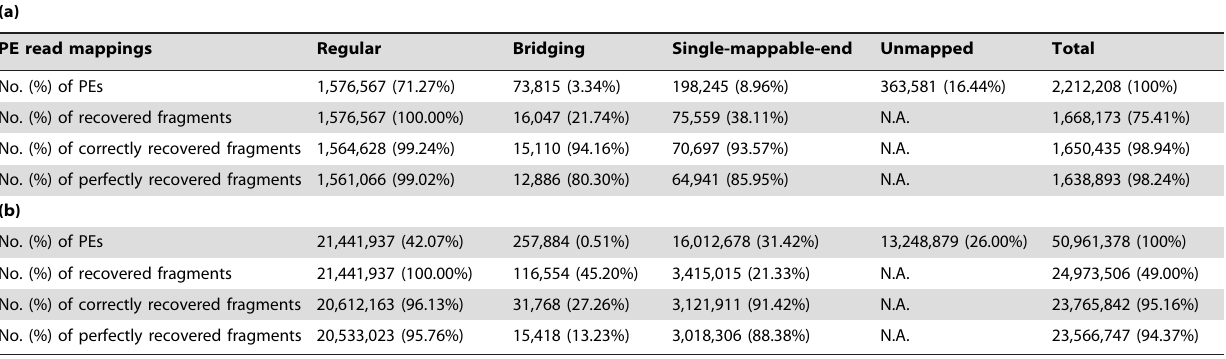
Table 8. Statistics of DNA fragments recovered from the PEs of two fungus